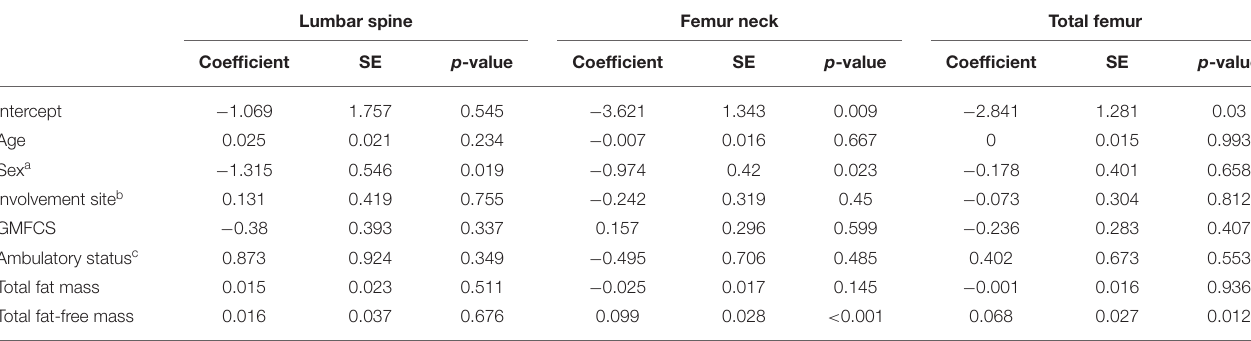
TABLE 4 | Multiple linear regression analysis for Z -scores in subjects with cerebral palsy. Lumbar spine Femur neck Total femur SE p -value Coefficient SE p -value Coefficient SE p